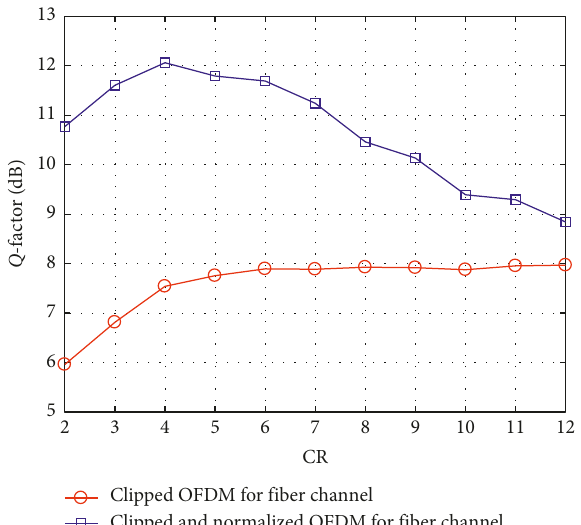
Figure 3: Q factor values as a function of the clipping ratio in clipped QPSK OFDM with and without normalization over the fiber channel, and the transmission is